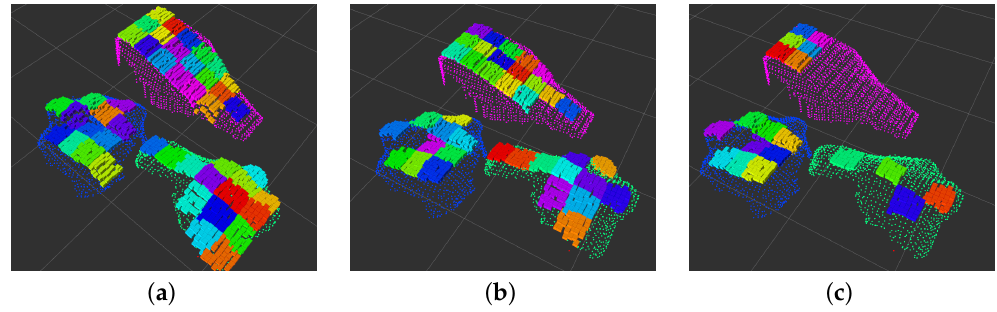
Figure 10. Results obtained by applying Rule 1 using different angular tolerances. ( a ) Tolerance 45°. ( b ) Tolerance 35° (used by the system). ( c ) Tolerance 20°.